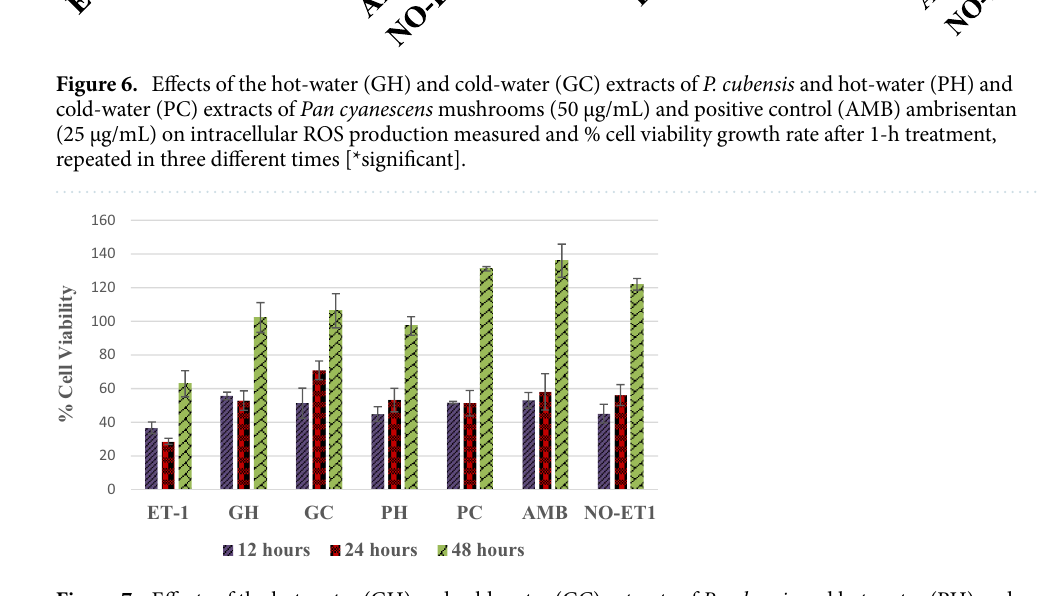
Figure 7. Effects of the hot-water (GH) and cold-water (GC) extracts of P. cubensis and hot-water (PH) and cold-water (PC) extracts of Pan cyanescens mushrooms (50 μg/mL) and positive control (AMB) ambrisentan (25 μg/mL) on % cell viability growth rate after 1-h treatment and measured over 12, 24 and 48 h, repeated in three different times.